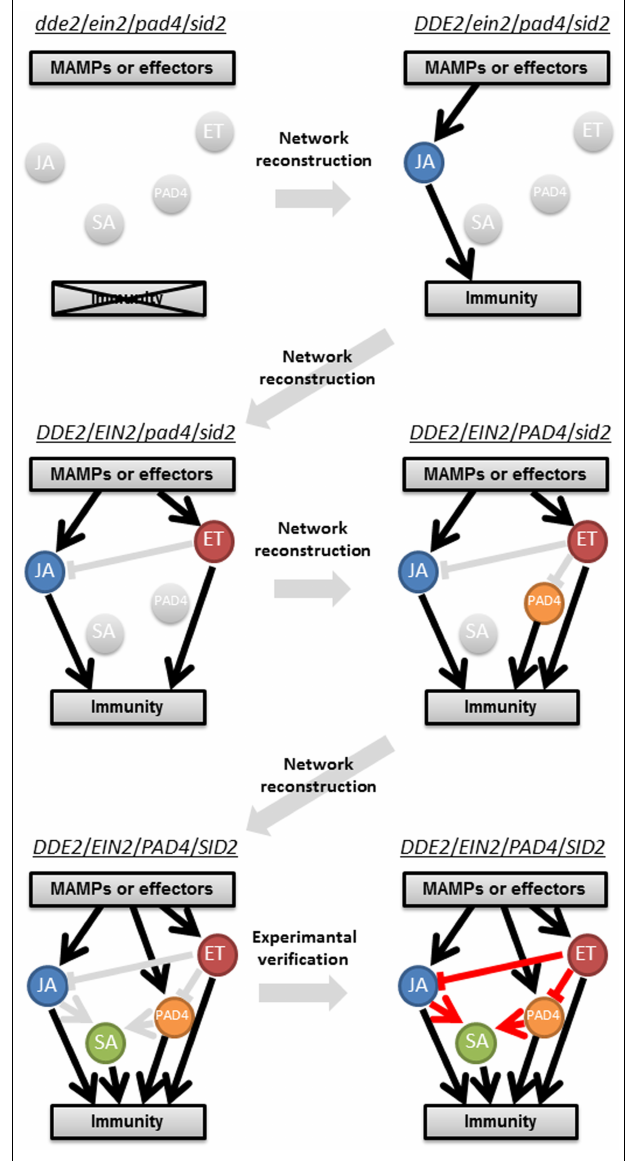
FIGURE 2 |A schematic representation of a stepwise reconstruction of a plant immune signaling network from a ground level state. The Arabidopsis dde2 / ein2 / pad4 / sid2- quadruple mutant is considered a ground level state of the plant immune signaling network consisting of the JA, ET, PAD4, and SA signaling sectors. Network reconstruction from the ground level state to the wild-type state via all combinatorial mutants is conducted to quantitatively measure contribution of the individual sectors to immunity (black lines) and activities (circles) and predict their regulatory relationships (gray lines).These predictions are experimentally verified (red lines). For simplicity, only one example is shown for triple, double, and single mutants.This approach was used inTsuda etal. (2009) and Kim etal. (2014).